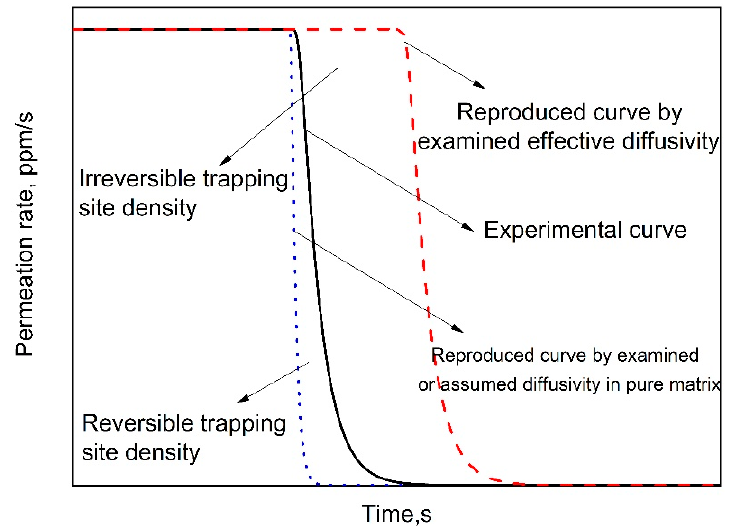
Figure 2. Proposed methods in literature to examine reversible and irreversible trapping side density at the decay process of hydrogen permeation curve.